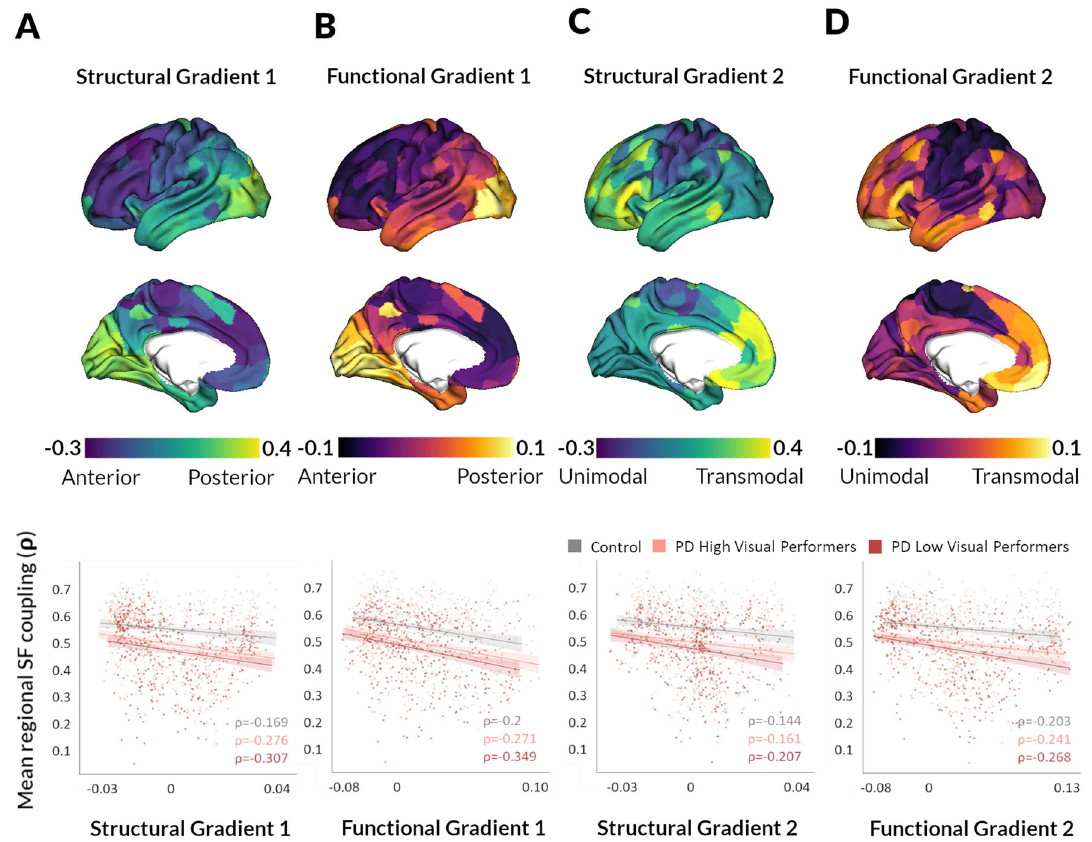
Fig. 4 Structural – functional connectivity decoupling in PD follows macroscale cortical gradients. Structural – functional connectivity (SC – FC) coupling is signi fi cantly associated with the fi rst principal structural ( A ) and functional gradients ( B ), which align with the anterior – posterior axis (visualised on the top: lower gradient values represent more anterior regions, higher gradient values more posterior regions). The correlation between mean SC – FC coupling and gradient value is plotted for each brain region in controls (grey), PD high visual performer (pink) and PD low visual performers (red) with ρ denoting the Spearman correlation coef fi cient. This correlation was seen in all groups but was more pronounced in PD than control participants and even more so in PD low visual performers (who are at higher risk of dementia). SC – FC coupling also re fl ected a brain region ’ s position along the second principal structural ( C ) and functional gradients ( D ), which re fl ect a unimodal-to-transmodal axis (visualised on the top: lower gradient values represent more unimodal regions, higher gradient values more transmodal regions). The correlation between mean SC – FC coupling and gradient value is plotted for each brain region in controls (grey), PD high visual performer (pink) and PD low visual performers (red) with ρ denoting the Spearman correlation coef fi cient. Again this relationship was more pronounced in PD low visual performers then PD high visual performers followed by control participants. The signi fi cance of regional correlations was evaluated using nonparametric spatial permutation